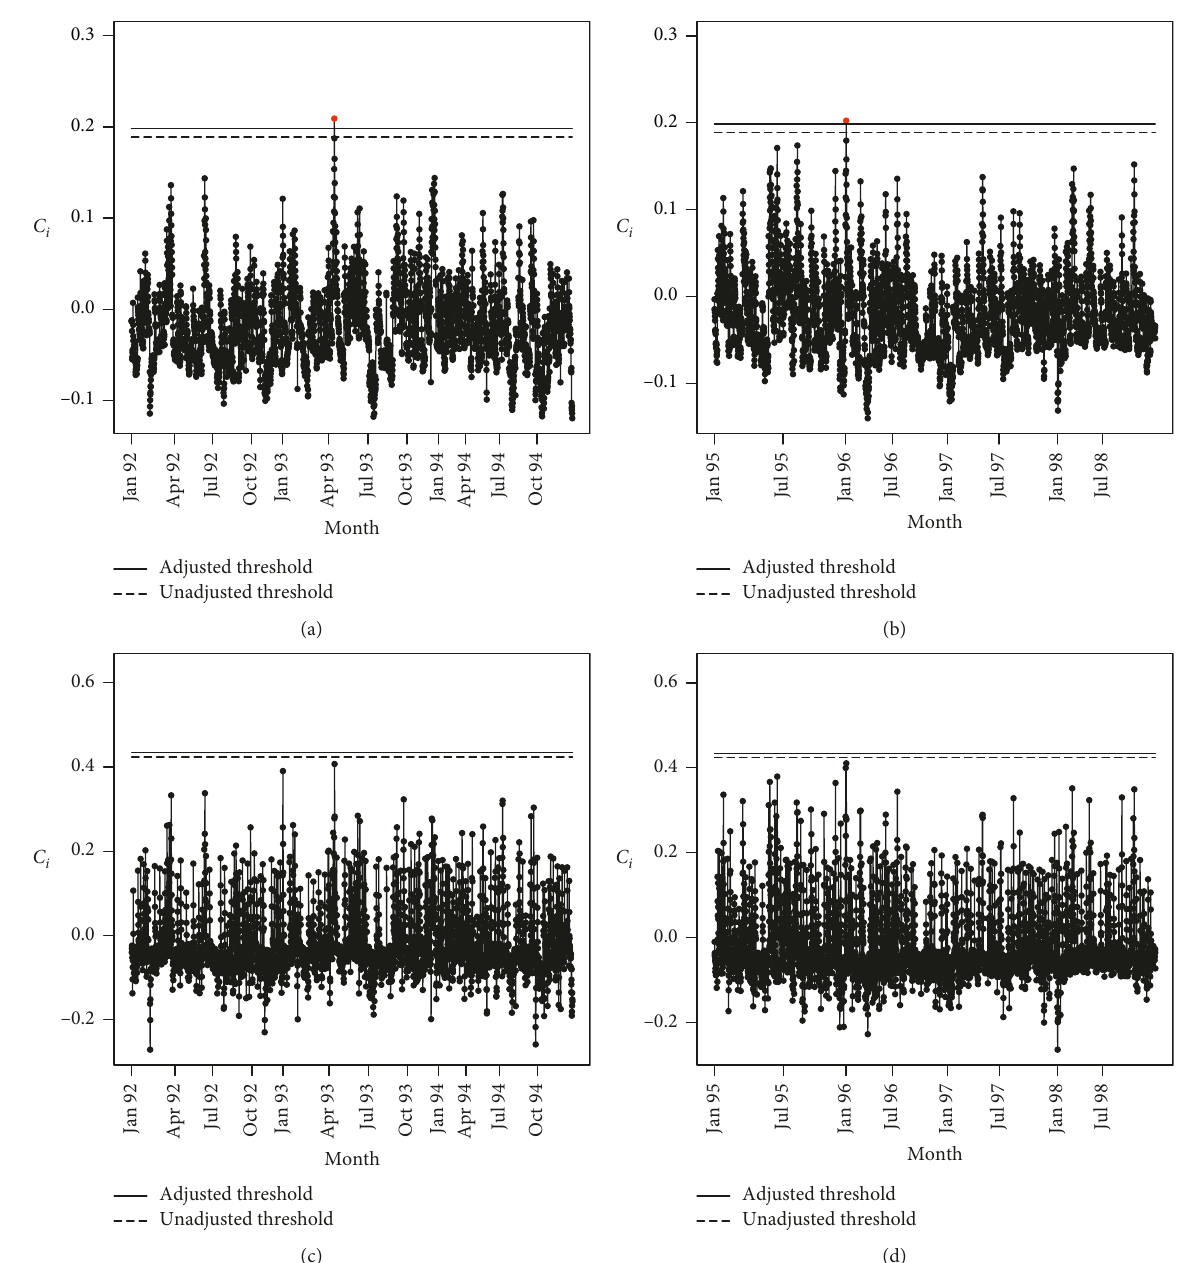
Figure 15: RA-EWMA chart for Phase-I and Phase-II assuming first three years as the Phase-I for 30 days mortality of cardiac surgery patients. (a) Phase-I chart, unadjusted UCL � 0.189 and adjusted UCL � 0.1983 and λ � 0.1. (b) Phase-II chart, unadjusted UCL � 0.189 and adjusted UCL � 0.1983 and λ � 0.1. (c) Phase-I chart, unadjusted UCL � 0.424 and adjusted UCL � 0.4354 and λ � 0.3. (d) Phase-II chart, unadjusted UCL � 0.424 and adjusted UCL � 0.4354 and λ �